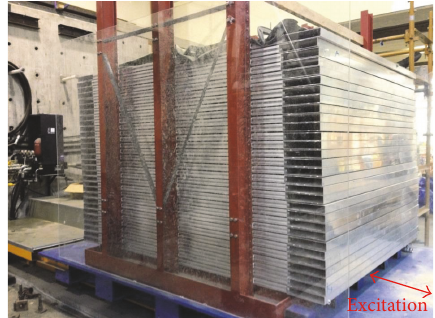
Figure 1: The laminar box on the shake